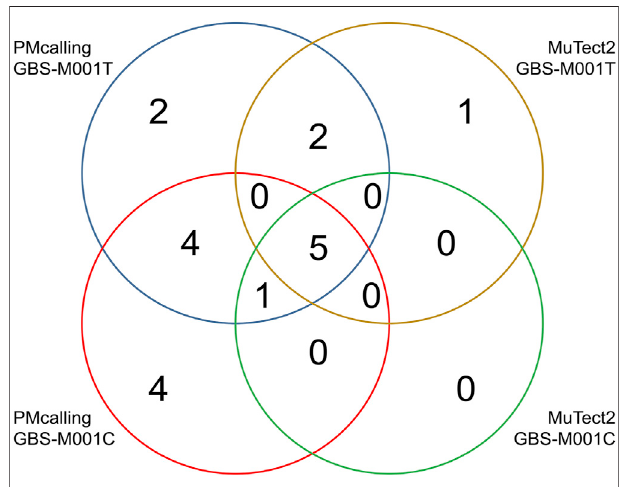
FIGURE4| Number ofPMsfoundin technical duplicates withPMcalling and